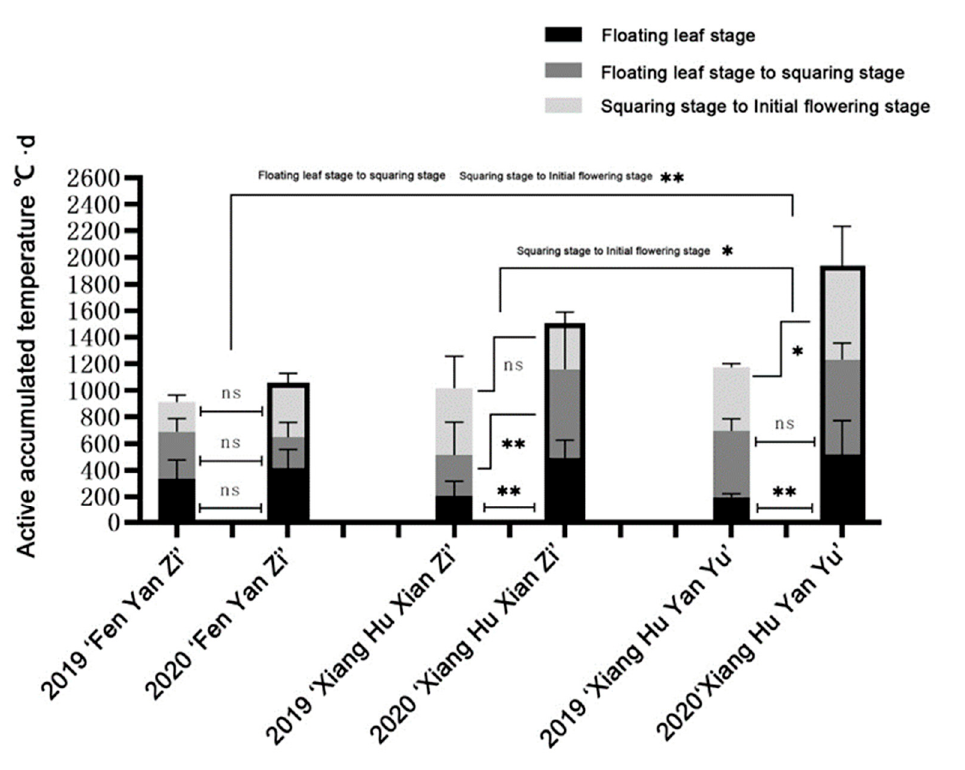
Figure 5. Comparison of accumulated temperature required in each growth period of three cultivars in 2019 and 2020. Asterisks denote t -test signi fi cance: * p < 0.05 and ** p < 0.01. ns, not signi fi cance. in 2019 and 2020. Asterisks denote t -test significance: * p < 0.05 and ** p < 0.01. ns, not significance.